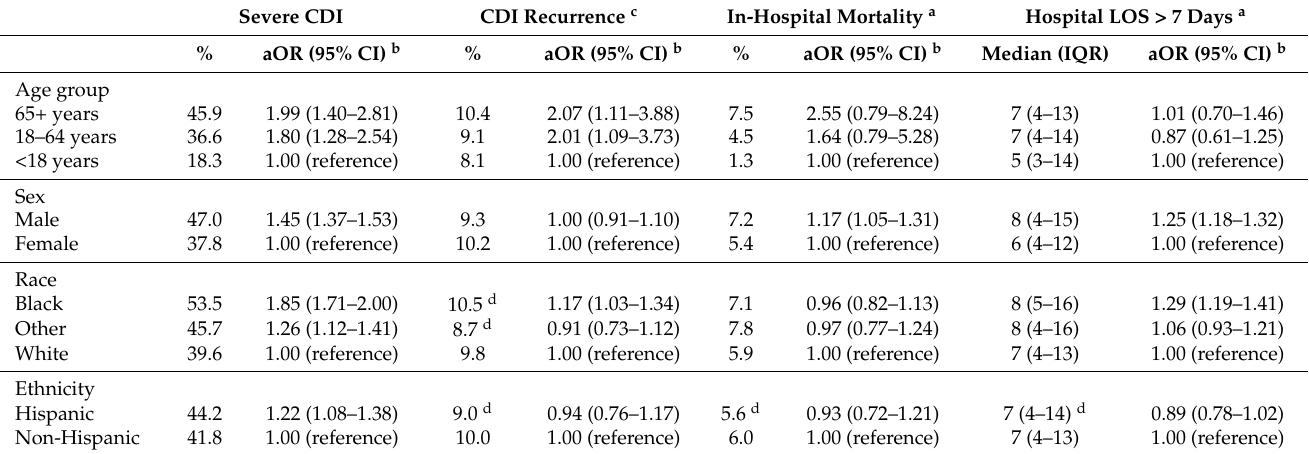
Table 4. CDI outcomes by patient subgroups for index